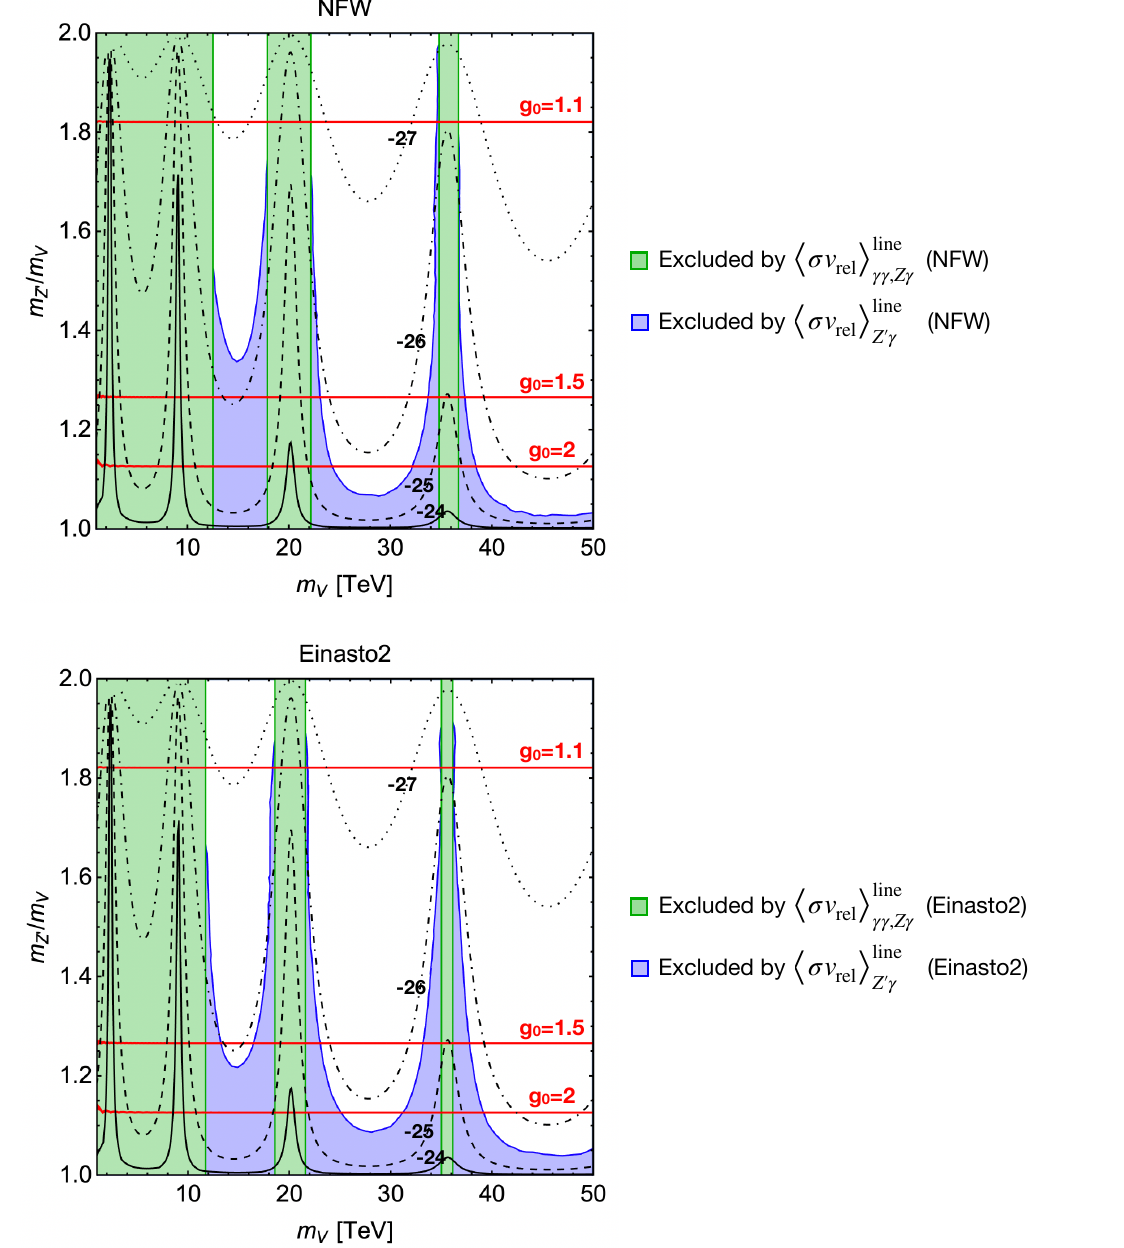
Figure 3 . The constraints on the line cross section for the different DM density profiles. The upper and lower panels show the constraints for the NFW profile [35] and the Einasto2 profile [34], respectively. The explanations for each plot are given in the caption of figure